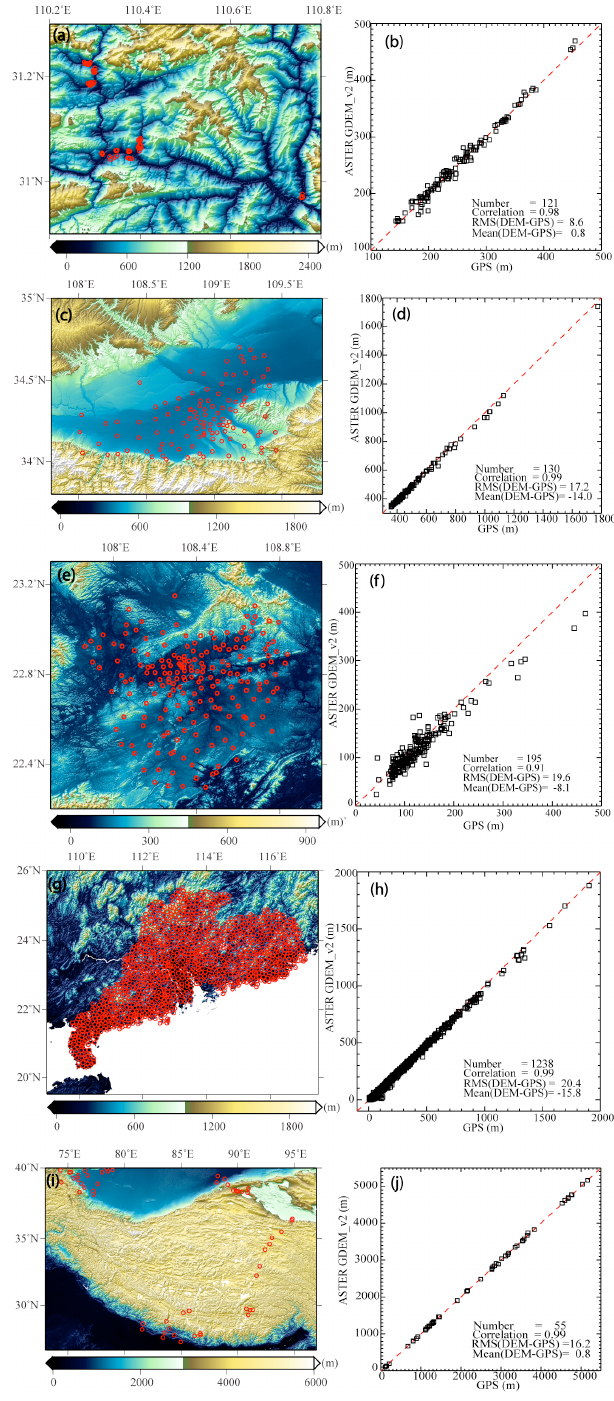
Figure 2. The shaded relief maps in the left column ( a , c , e , g , i ) respectively stand for the five study areas (Three Gorges, Xi’an, Nanning, Guangdong and Tibetan plateau) with the locations of static GPS points plotted on the topography data (ASTER GDEM, SRTM and SRTM30). Red circles indicate GCPs. ( b ) Scatterplots of ASTER GDEM2 vs. static GPS heights are plotted in the right column ( b , d , f , h , j) corresponding to the left locations. The number of GPS points and the values of correlation, RMS and mean errors are provided in each scatterplot. The red dashed line stands for the line of perfect